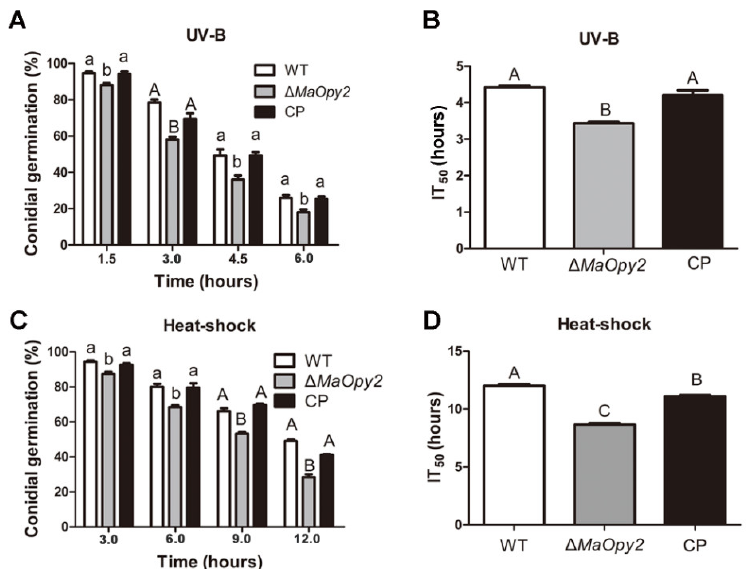
Figure 2. Effect of MaOpy2 on UV-B irradiation and heat shock tolerance. ( A ) Conidial germination treated with UV-B irradiation for 1.5 h, 3.0 h, 4.5 h and 6.0 h. ( B ) The IT 50 of UV-B irradiation. ( C ) Germination rates treated with heat shock for 3.0 h, 6.0 h, 9.0 h and 12.0 h. ( D ) IT 50 of heat shock. A & B and a & b presented the significant difference at p < 0.01 and p < 0.05, respectively.